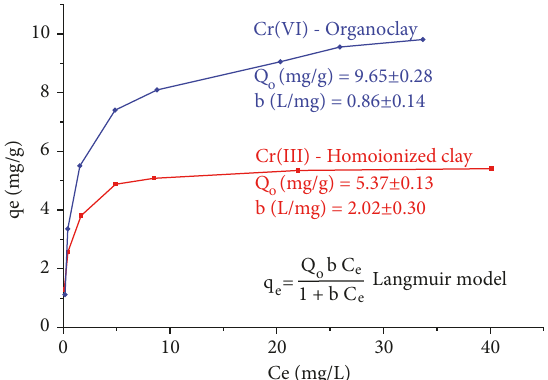
Figure 10: Adsorption isotherms of Cr(III) and Cr(VI) at 20 ∘ C and V=50mL in homoionized clay (pH 3.5, 0.96 g adsorbent) and organoclay (pH 3.4, 0.44 g